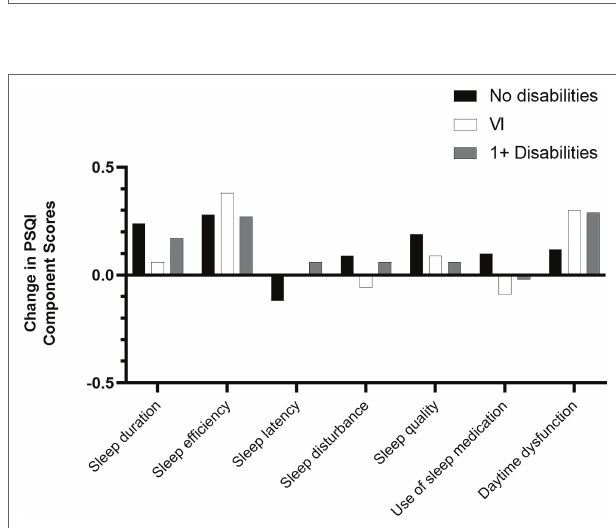
FIGURE 2 | Change in PSQI component mean